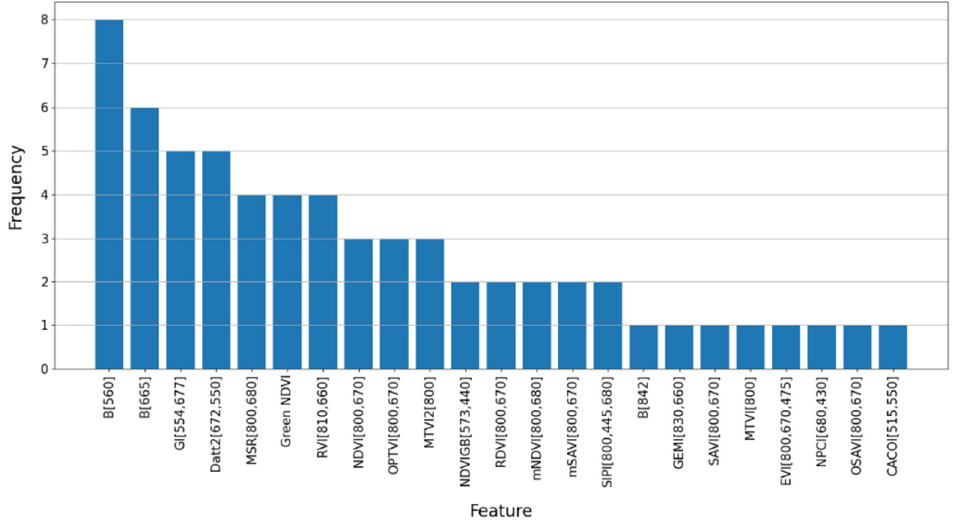
Figure 11. Band and index frequencies returned by temporal SFFS.